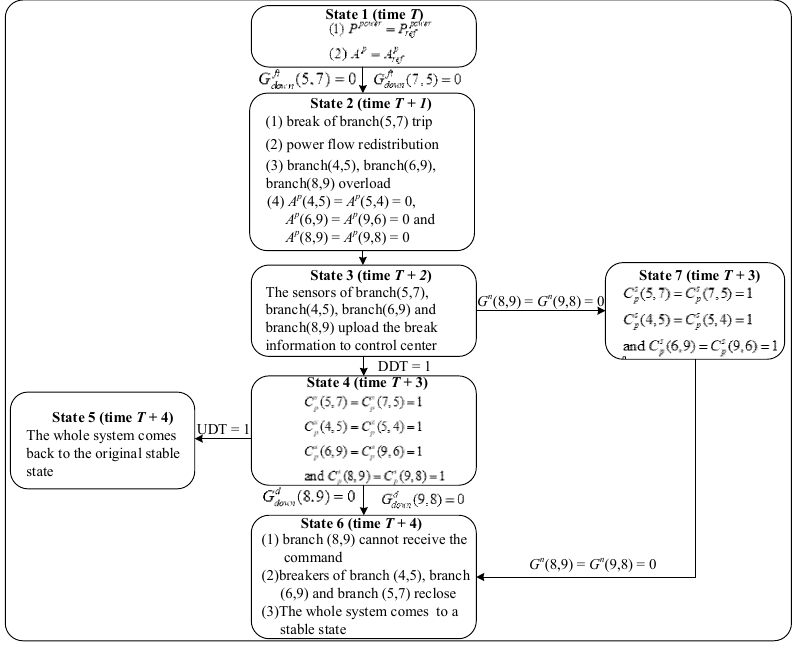
Figure 7. State machine of cyber faults state of CPPS.